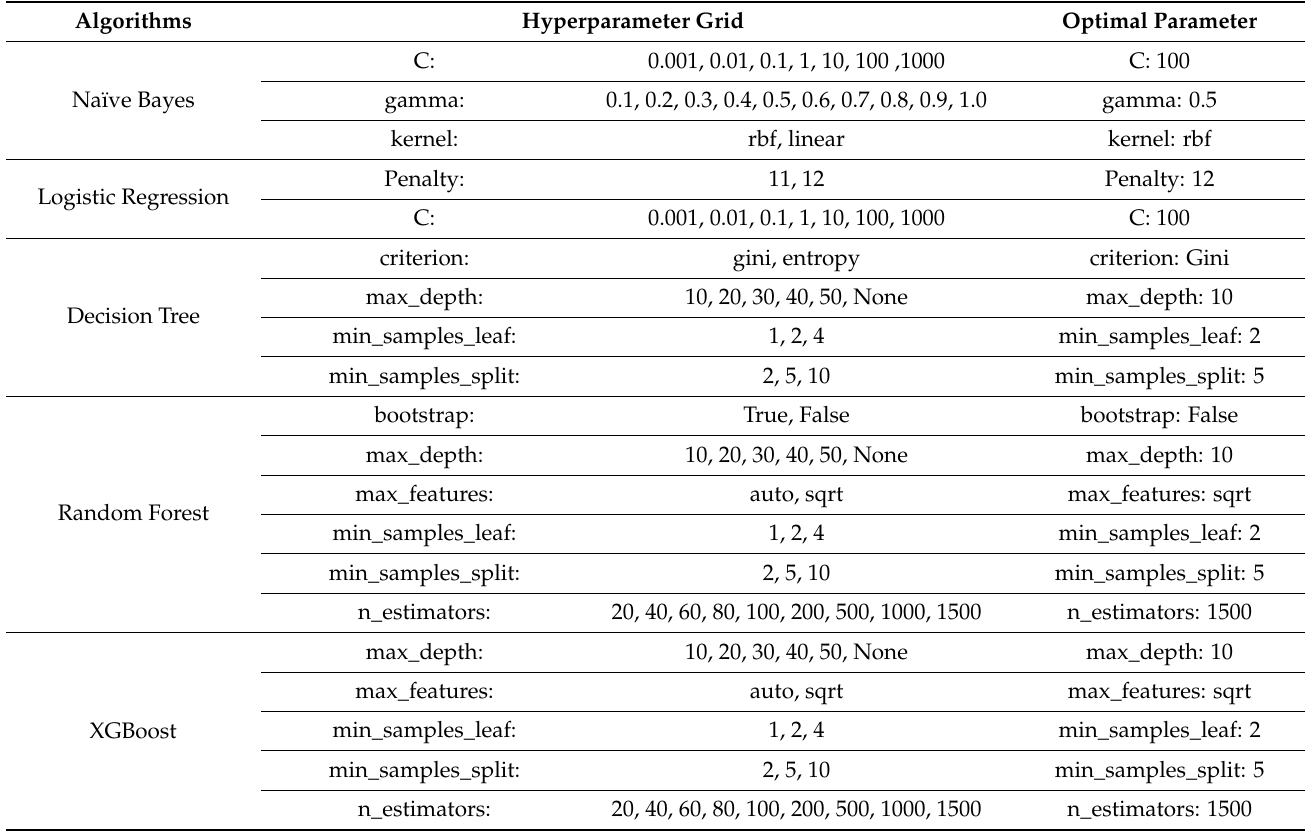
Table 2. Hyperparameter search grid and optimal value for each machine learning